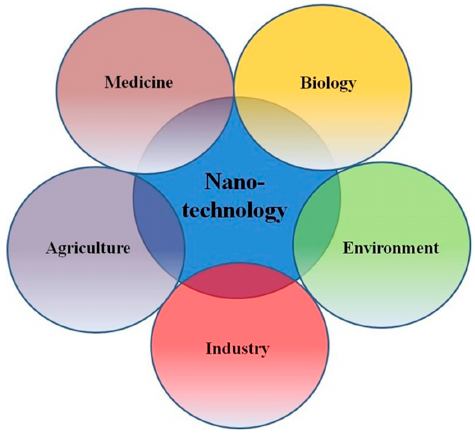
Figure 1. Nanotechnology transformative innovations in medicine, agriculture, industry, environment, and basic biological sciences.